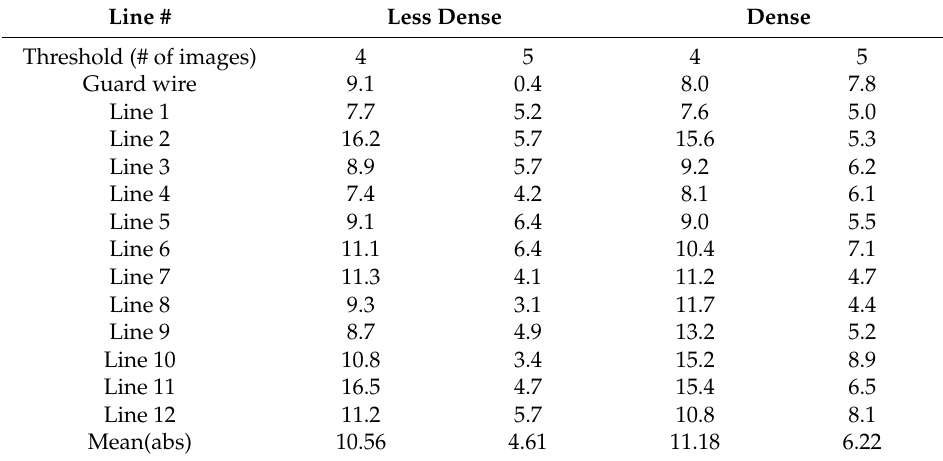
Table 4. Power line interpolation residuals in RMSE (cm).